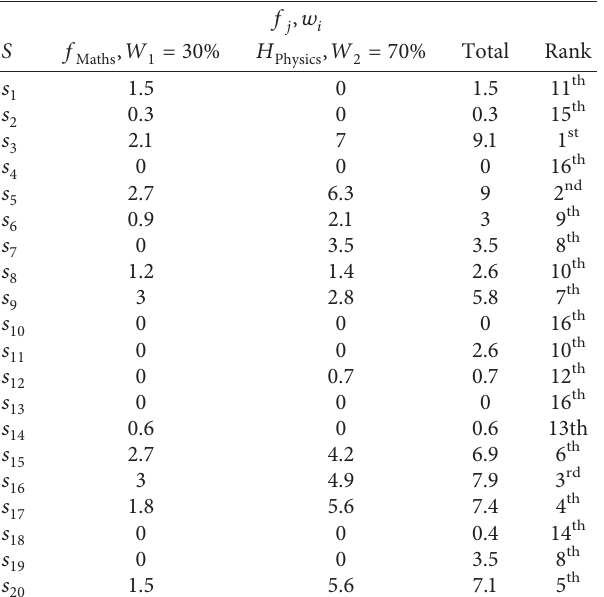
Table 4: Students’ weight